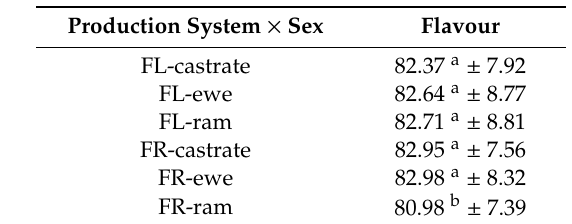
Table 5. Means ( ± s.d.) depicting the e ff ect of the two-way interaction (production system × sex) on the flavour score of Dorper